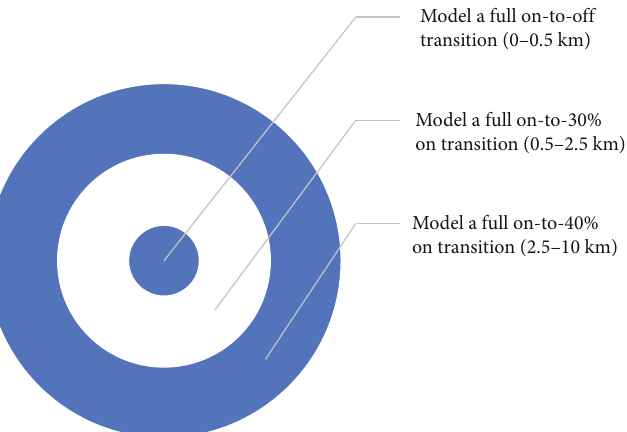
Figure 11: Methodology to incorporate aggregations of multiple solar PV systems on a given distribution feeder into the proposed fl icker screen. The voltage change on the line that results from this model can then be compared to our fl icker screening threshold of